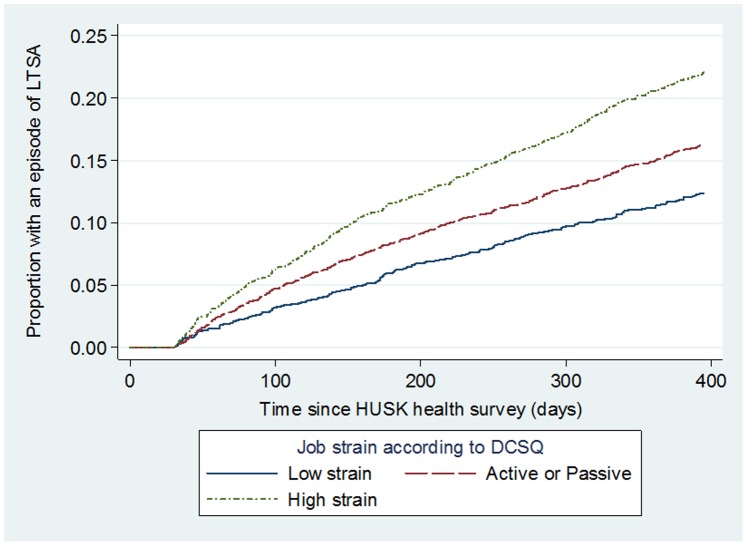
Unadjusted risk of participants having an episode of long term sickness absence (LTSA) by job strain.